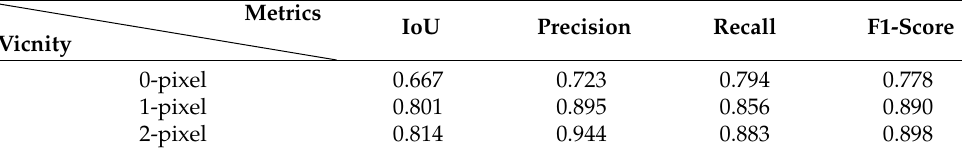
Table 7. Numerical results obtained using vanilla version of our proposed method.